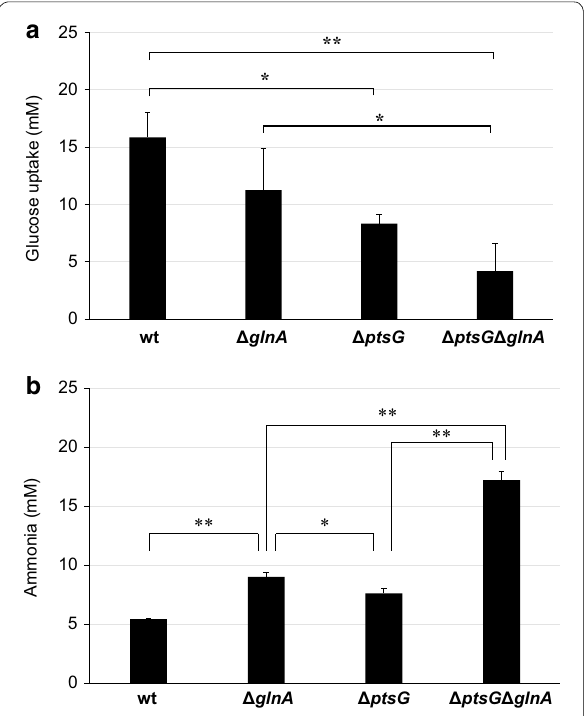
Fig. 4 Effects of ptsG and glnA disruption on glucose uptake ( a ) and ammonia production ( b ) in the M9-yeast extract medium with 50 mM glucose. Glucose uptake and ammonia production was measured 2 h and 26.5 h after the start of incubation at 37 °C in the M9-yeast extract medium, respectively. Values are expressed as the mean SD (n 3). Statistical significance was determined by Tukey’s SD (n 3). * Statistical ± = ± = test (*P < 0.05, **P <